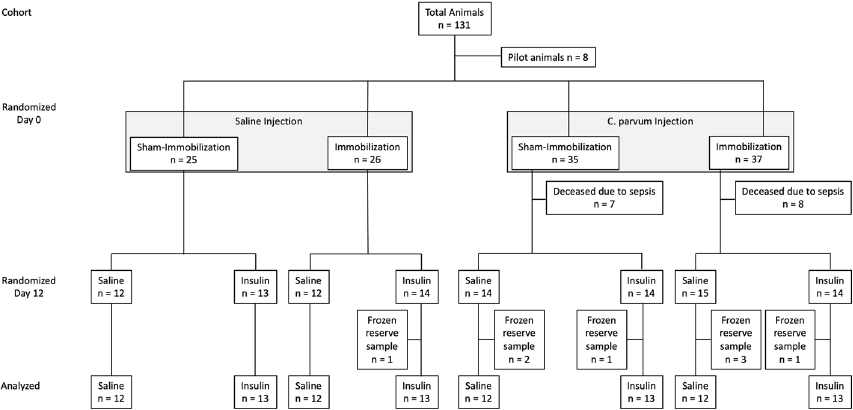
Fig. 1 Study scheme. Single-hit and double-hit models of systemic inflammation and/or immobilisation with and without